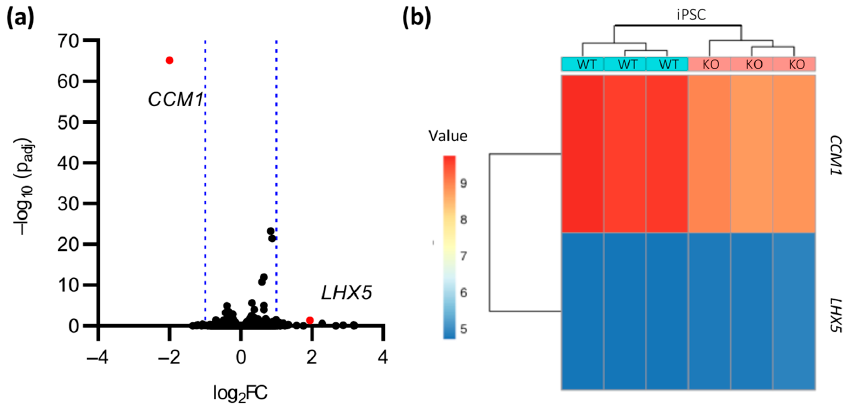
Figure 5. Gene expression differences in CCM1 − / − iPSCs. ( a ) Volcano plot of up- or downregulated genes in CCM1 − / − iPSCs. The log 2 fold change (log 2 FC) of the normalized mean hit counts is plotted against the negative log 10 adjusted p value ( − log 10 (p adj )). Differentially expressed genes (= p adj < 0.05 and |log 2 FC| > 1) are marked in red; ( b ) heatmap of differentially expressed genes in CCM1 − / − iPSCs. Shown are regularized log transformed read counts (= value) for CCM1 − / − (KO) and CCM1 +/+ (WT) iPSCs. n = 3 per genotype.